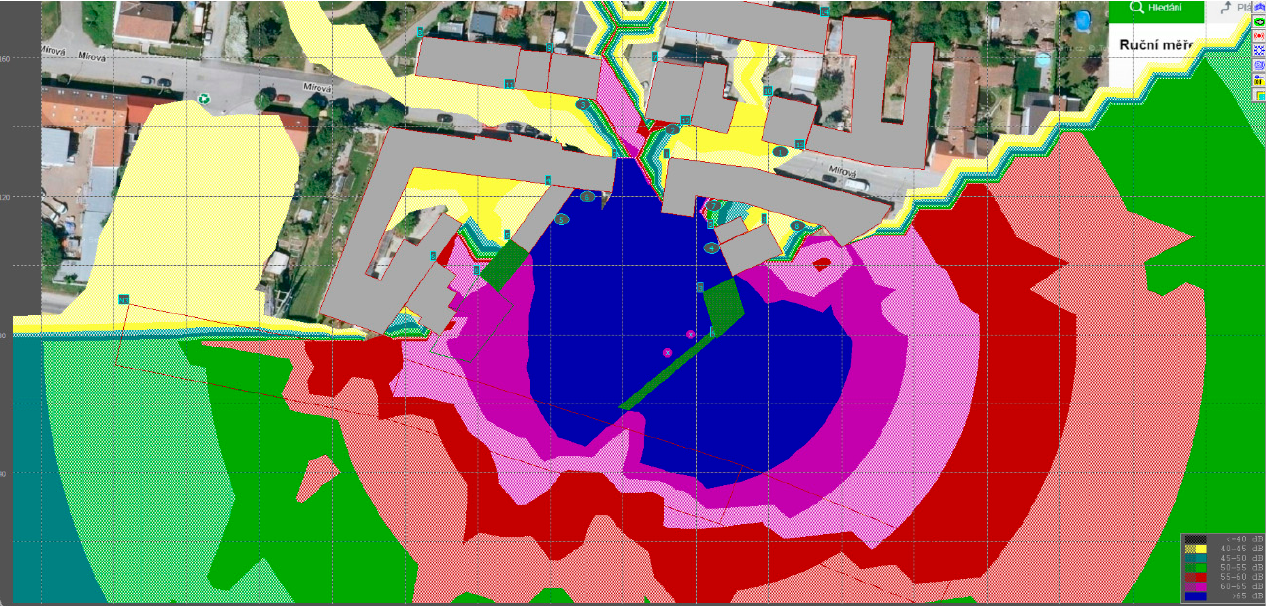
Figure 20. Colour map of isophone bands after considering acoustically significant elements (without construction site fencing or a solid gate) for final landscaping in the investigated area, with the deployment of only the machine for the transfer and deposition of soil.